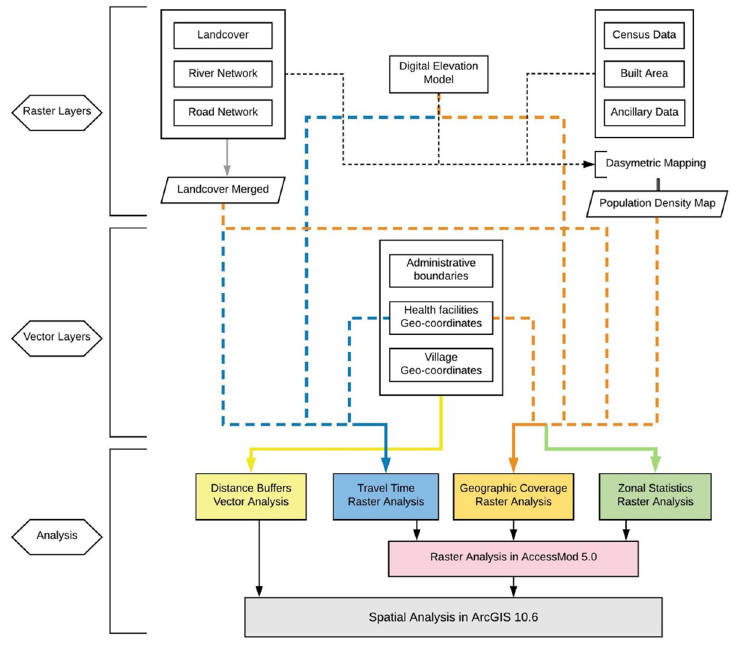
Fig 2. Flow chart of